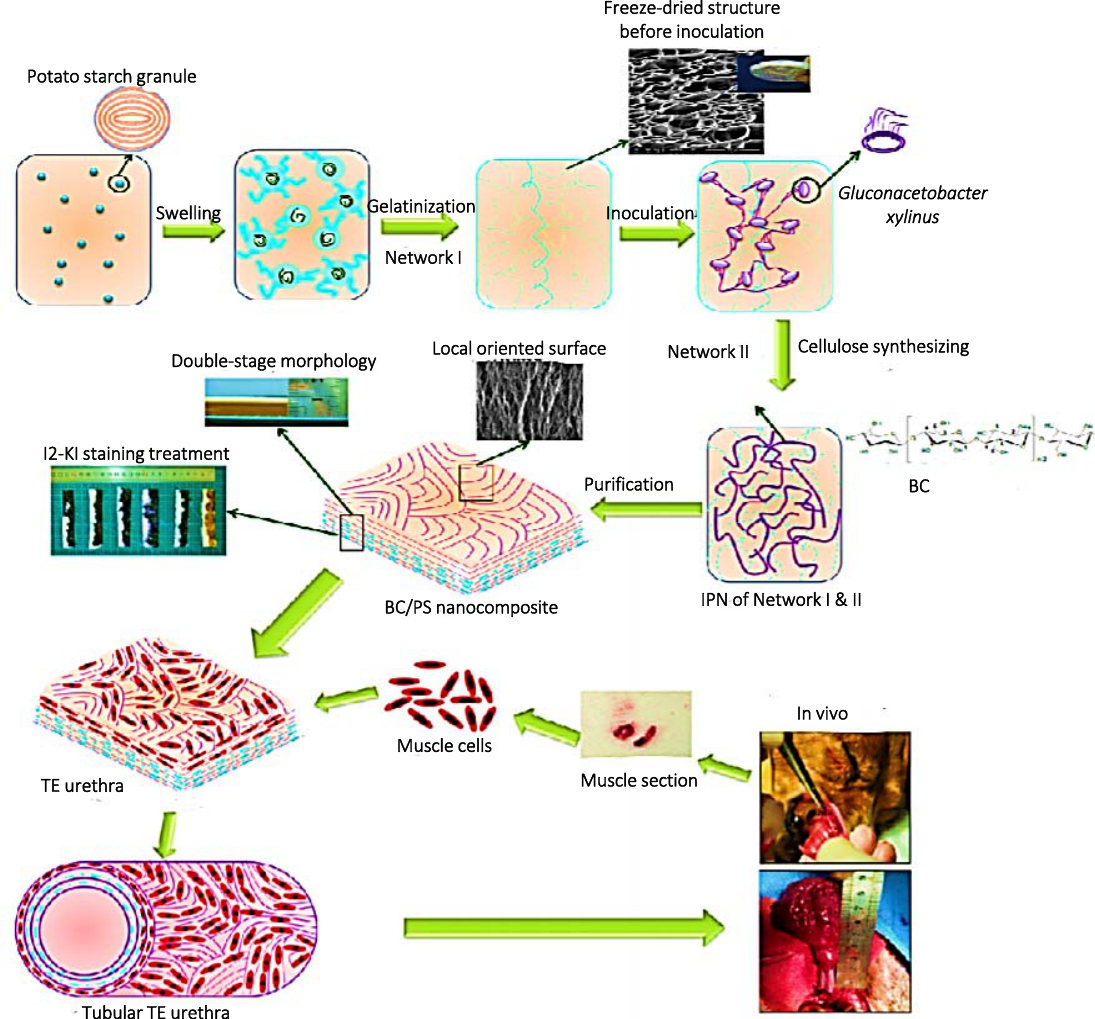
Figure 3. Schematic illustration of biosynthesis of BC / potato starch (PS) composites and experimental design in fabrication of tissue engineered urethra. Reprinted with permission from Ref. [10] Copyright (2016) American Chemical